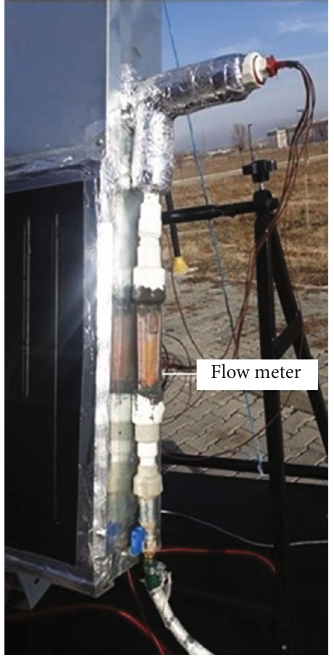
Figure 6: Connection of the fl ow meter to the experimental